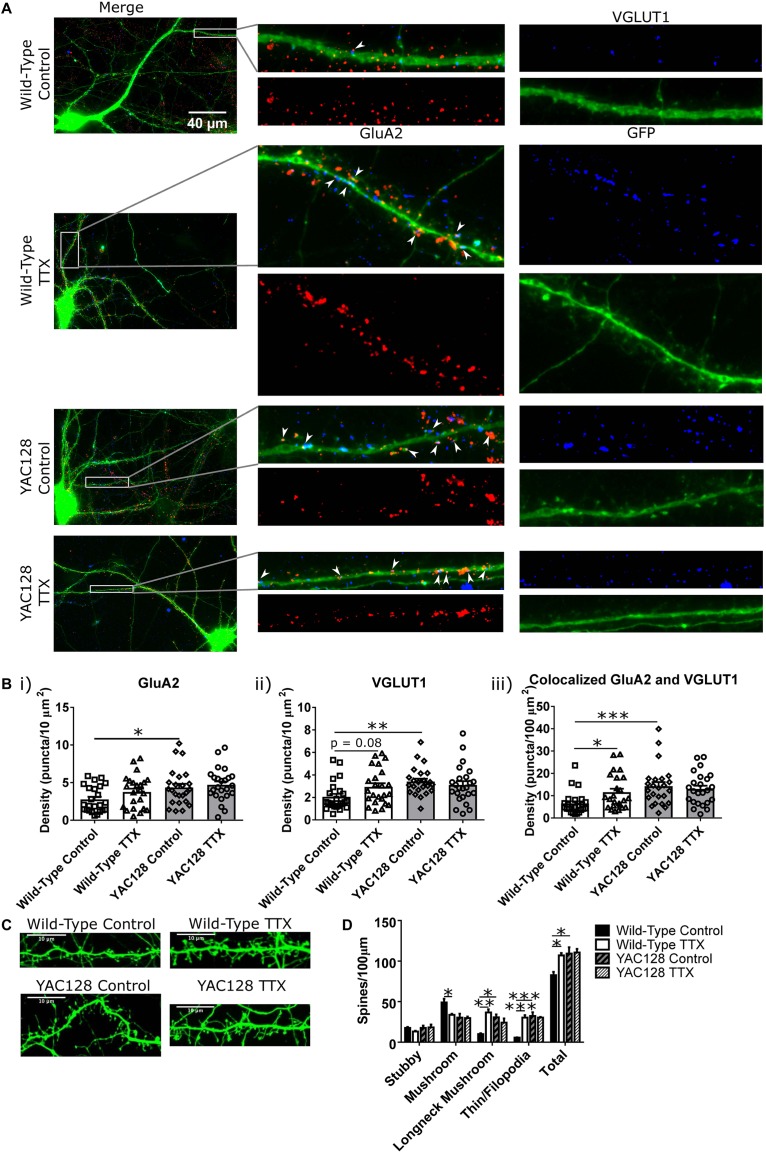
Synaptic changes underlying homeostatic plasticity. (A) Representative images of CPNs filled with GFP (green), and stained for GluA2 (red), and VGLUT1 (blue). (B) Density of (i) GluA2 (genotype p < 0.01, two-way ANOVA), (ii) VGLUT1 (genotype p < 0.05, genotype/TTX interaction p < 0.05, two-way ANOVA), and (iii) colocalised GluA2 and VGLUT1 puncta (genotype p < 0.01, genotype/TTX interaction p < 0.05, two-way ANOVA) on CPN dendrites. YAC128 control CPNs had a higher density of all three types of puncta than WT control CPNs (GluA2 ∗p < 0.05, Bonferroni post hoc t-test; VGLUT1 ∗∗p < 0.01, Bonferroni post hoc t-test; colocalised ∗∗∗p < 0.001, Bonferroni post hoc t-test). WT CPNs treated with TTX also showed a tendency to increased VGLUT1 density (p = 0.08, Bonferroni post hoc t-test) and significantly increased density of colocalised GluA2 and VGLUT1 puncta (∗p < 0.05, Bonferroni post hoc t-test) relative to WT control CPNs. YAC128 CPNs treated with TTX did not differ from either YAC128 control CPNs or WT CPNs treated with TTX (p > 0.99, Bonferroni post hoc t-test; cells per group n = 24, culture batch N = 3). (C) Representative images of spines on CPNs filled with GFP. (D) Spine density, grouped by morphology. WT control CPNs had a higher density of mushroom spines than TTX-treated WT CPNs (∗p < 0.05, Bonferroni post hoc t-test; genotype p < 0.05, two-way ANOVA), as well as fewer longneck mushroom spines (mushroom spines with necks > 1 μm in length; ∗∗p < 0.01, Bonferroni post hoc t-test) and filopodia/thin spines (∗∗∗p < 0.001, Bonferroni post hoc t-test). Compared to YAC128 control CPNs, WT control CPNs also had fewer longneck mushroom spines (∗p < 0.05, Bonferroni post hoc t-test; TTX p < 0.05, TTX/genotype interaction p < 0.01, two-way ANOVA) and filopodia/thin spines (∗∗∗p < 0.001, Bonferroni post hoc t-test; TTX p < 0.01, genotype p < 0.01, TTX/genotype p < 0.01, two-way ANOVA). WT control CPNs also had a lower total spine density than TTX-treated WT CPNs (∗p < 0.05, Bonferroni post hoc t-test) and YAC128 control CPNs (∗p < 0.05, Bonferroni post hoc t-test; TTX p < 0.05, genotype p < 0.05, two-way ANOVA; culture batches N = 3).